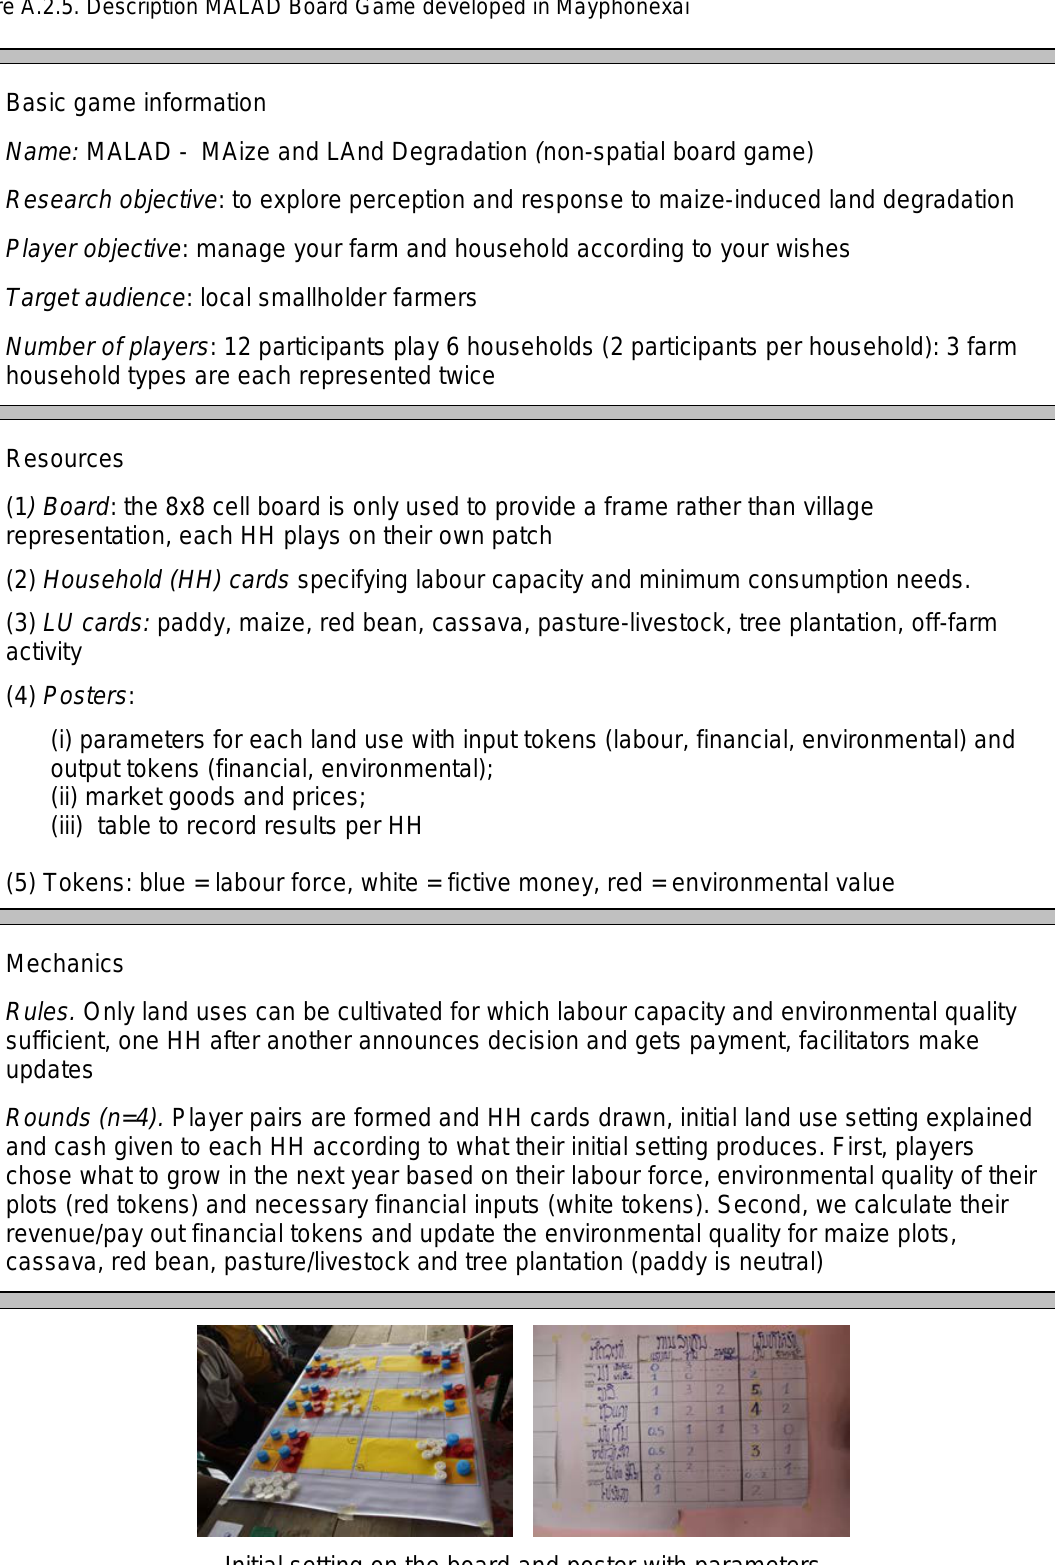
Figure A.2.5. Description MALAD Board Game developed in